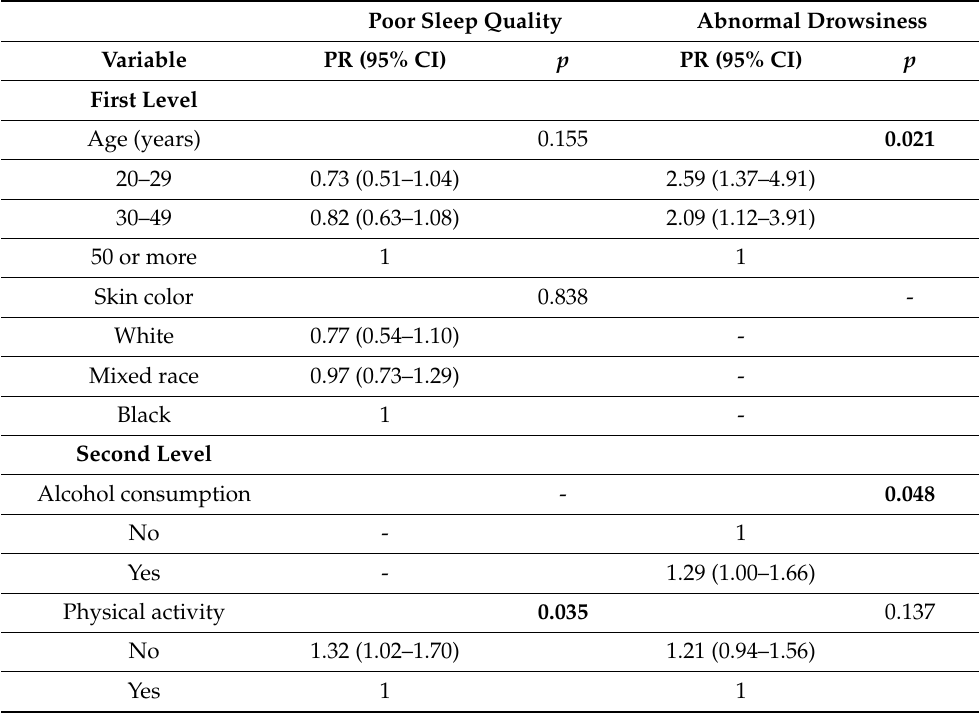
Table 2. Multiple analysis of the association of poor sleep quality and drowsiness and risk factors in health professionals ( n =